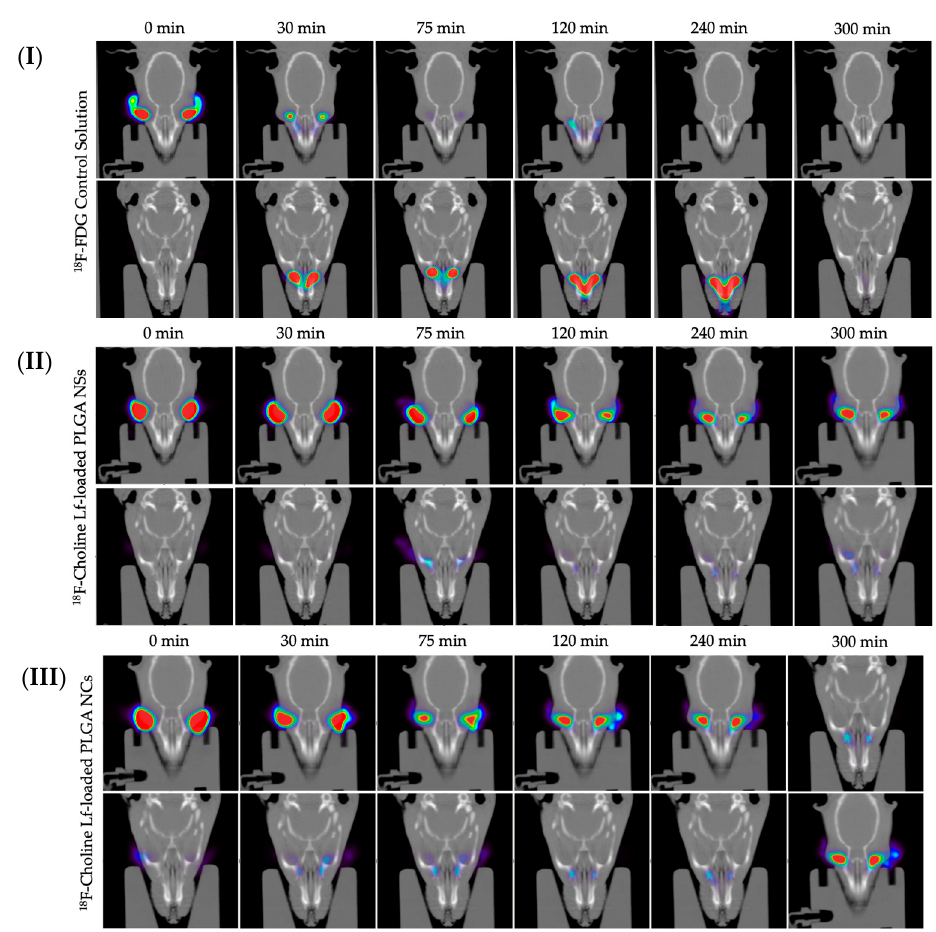
Figure 18. Fused PET/CT images during the 5 h studied interval. ( I ) 18 F-FDG buffered aqueous solution, ( II ) 18 F-Choline radiolabeled PLGA NSs and ( III ) 18 F-Choline radiolabeled PLGA NCs.